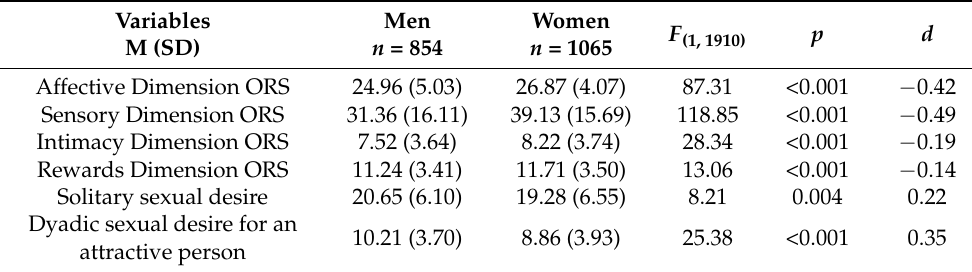
Table 2. Sex differences in the four dimensions of the subjective orgasm experience and in the two types of sexual